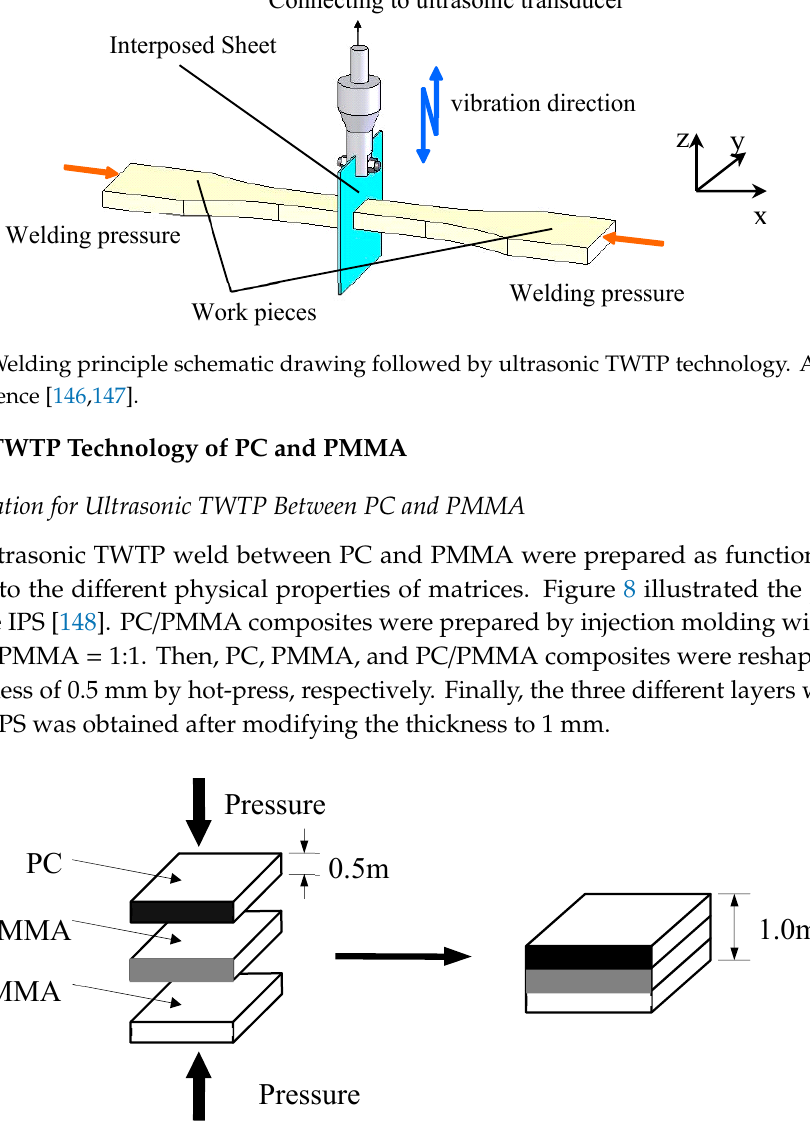
Figure 8. Schematic diagram of IPS preparation for PC-PMMA weld. Adapted from Reference [148].